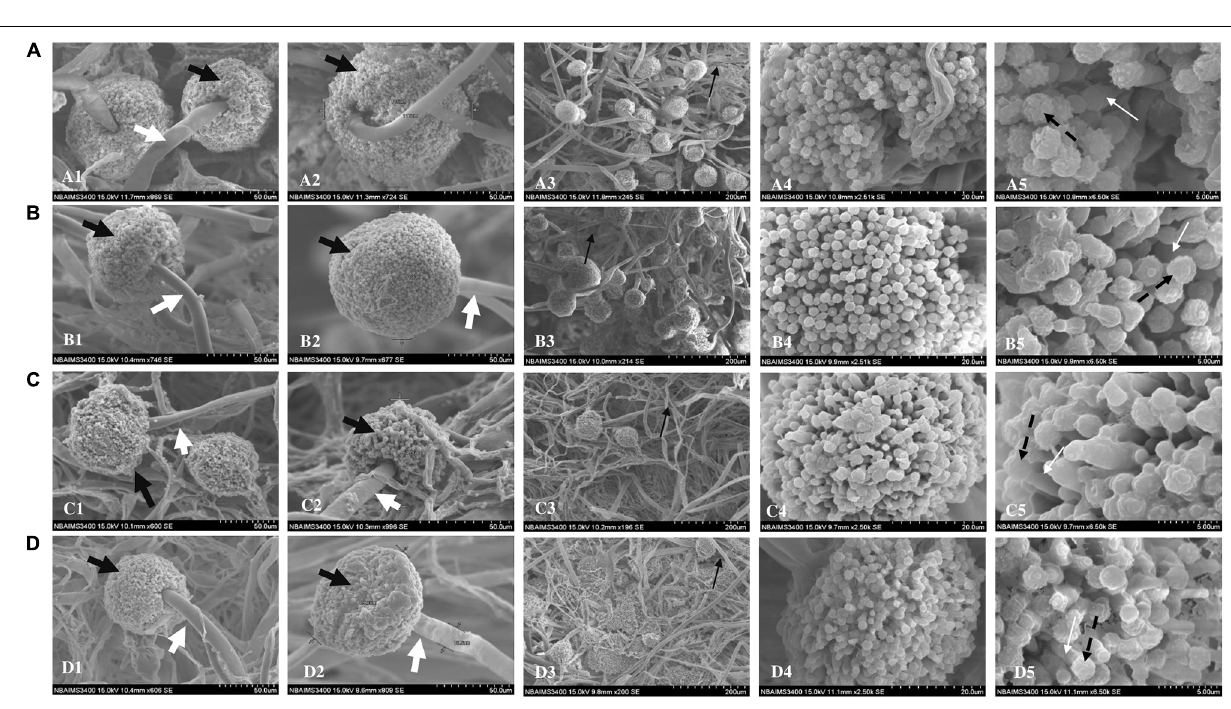
FIGURE 4 | Scanning electron micrographs of A. nidulans (A) without siderophore treatment: (1–2) Conidiophores and conidial heads; (3) Hyphae; (4) Conidial head (magnification—20 µ m); (5) magnified conidia and phialides (5 µ m); (B) treated with 18 µ g/ml of siderophore: (1–2) Conidiophores and conidial heads; (3) Hyphae; (4) Conidial head (magnification—20 µ m); (5) magnified conidia and phialides (5 µ m); (C) treated with 36 µ g/ml of siderophore: (1–2) Conidiophores and conidial heads; (3) Hyphae; (4) Conidial head (magnification—20 µ m); (5) magnified conidia and phialides (5 µ m); (D) treated with 44 µ g/ml of siderophore: (1–2) Conidiophores and conidial heads; (3) Hyphae; (4) Conidial head (magnification—20 µ m); (5) magnified conidia and phialides (5 µ m); Black bold arrow—conidial head; White bold arrow—conidiophores; Black thin arrow—hyphae; Black dashed arrow—conidia; White thin